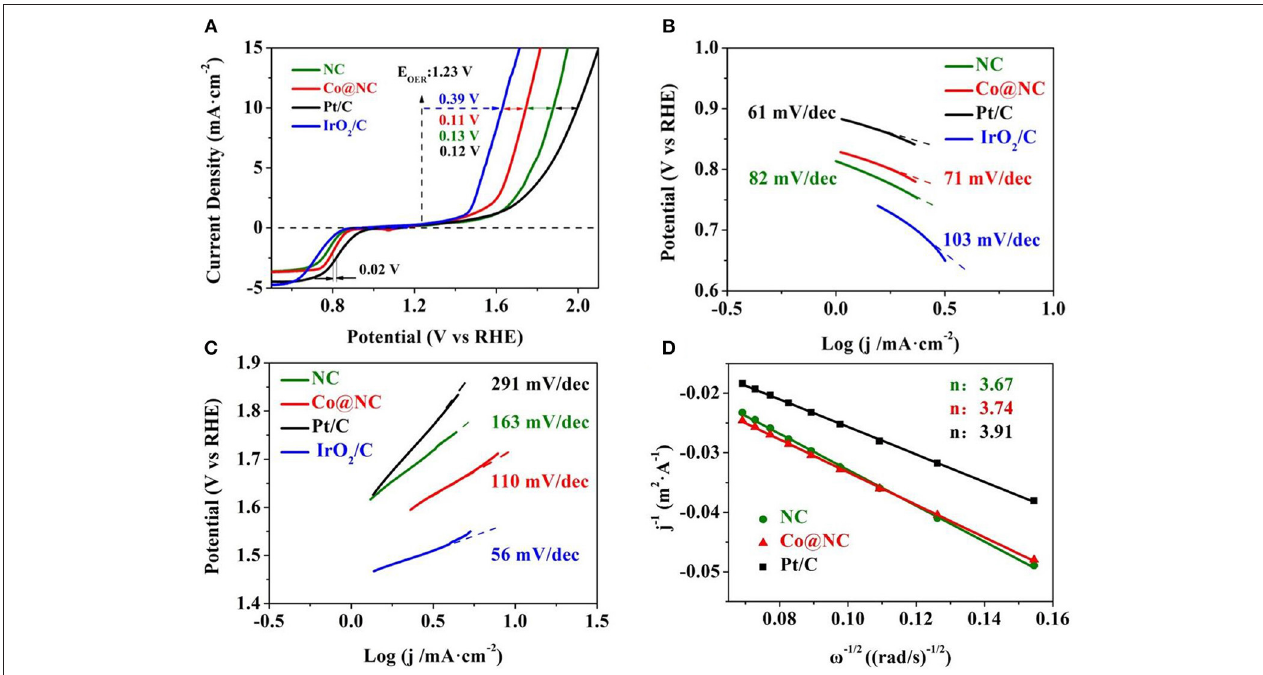
FIGURE 3 | (A) ORR and OER polarezation curves of Co@NC, NC, and Pt/C (electrolyte: O 2 -saturated 0.1M KOH, scan rate: 10 mV · s − 1 , rotational speed: 1,600 rpm). Tafel plots of Co@NC, NC, Pt/C and IrO 2 /C for (B) ORR; (C) OER. (D) Koutecky-Levich (K-L) plots of NC, Co@NC, and Pt/C at 0.5V.